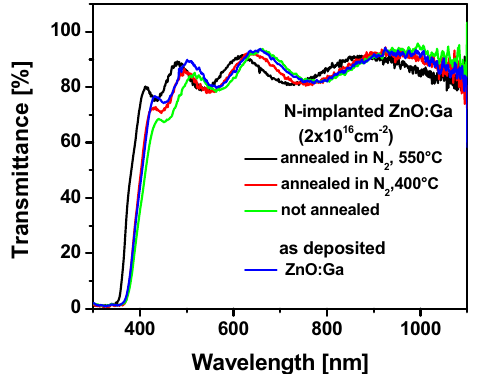
Fig. 7. Optical transmittance spectra of: (a) as deposited ZnO:Ga films (blue line), and N-implanted ZnO:Ga films (im- plant dose of 2 × 10 16 cm − 2 ) (b) not annealed (green line); (c) annealed in N 2 at 400 for 10 s (red line); (c) annealed in N 2 at 550 for 10 s (black line).